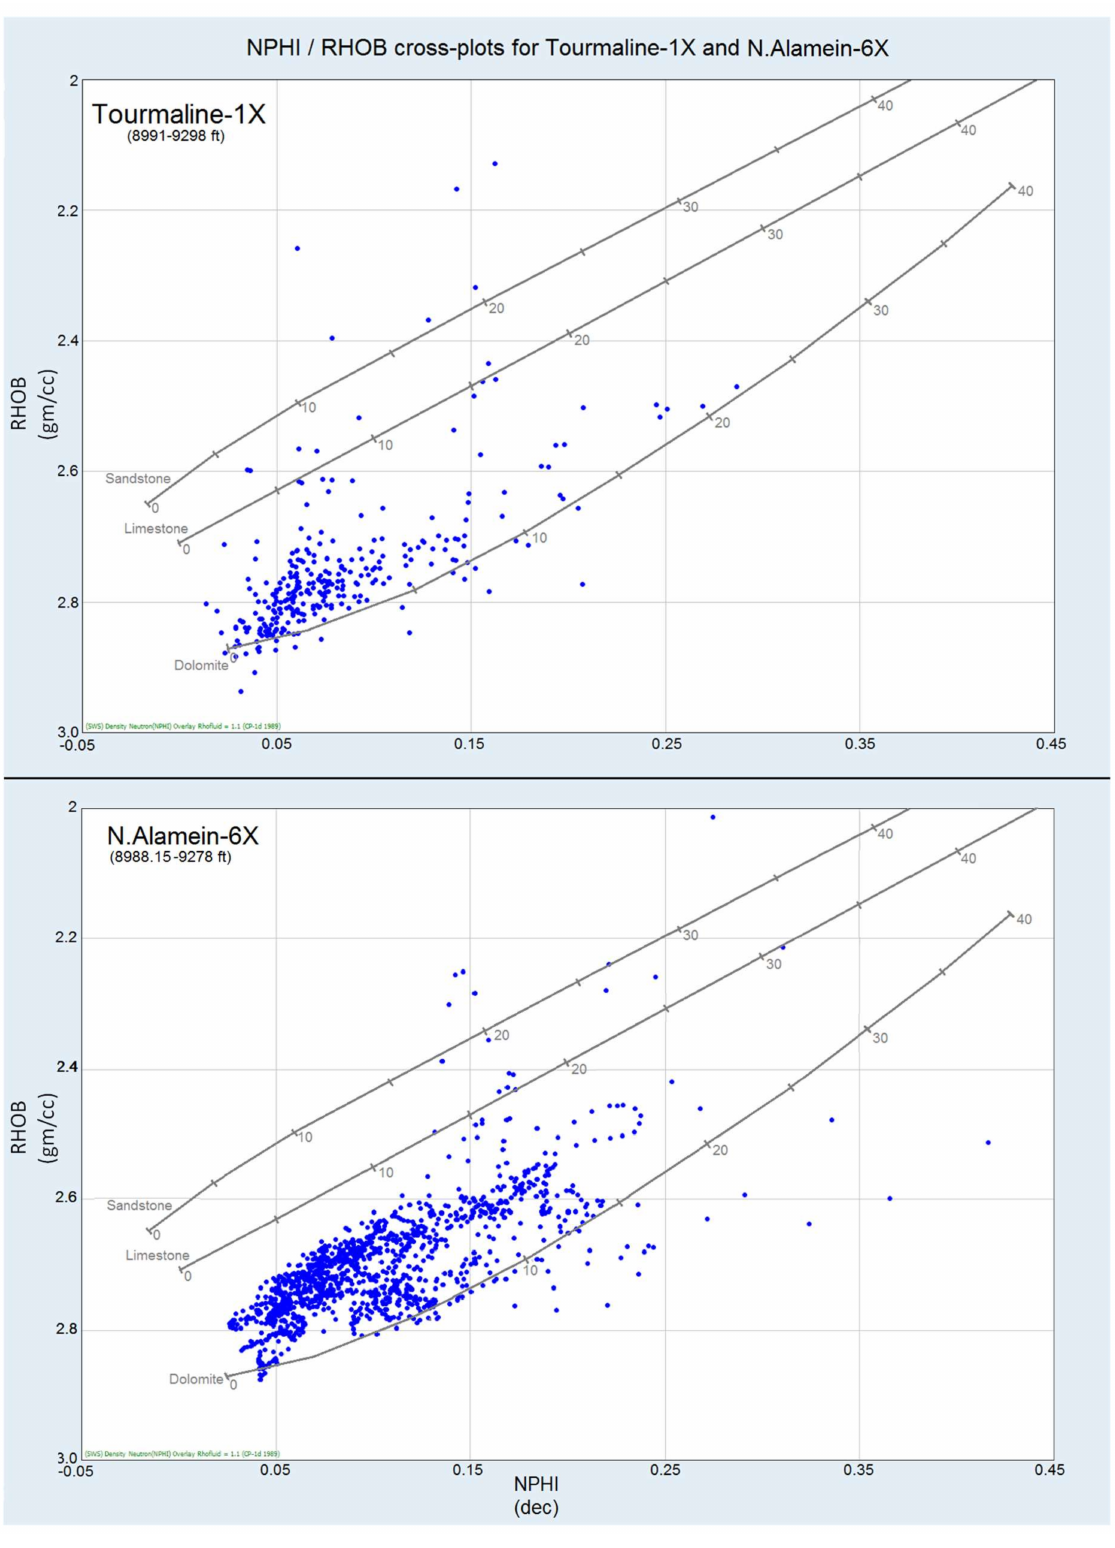
Figure 5. Neutron (NPHI)–Density (RHOB) lithology cross-plots for Tourmaline-1X and N.Alamein-6X